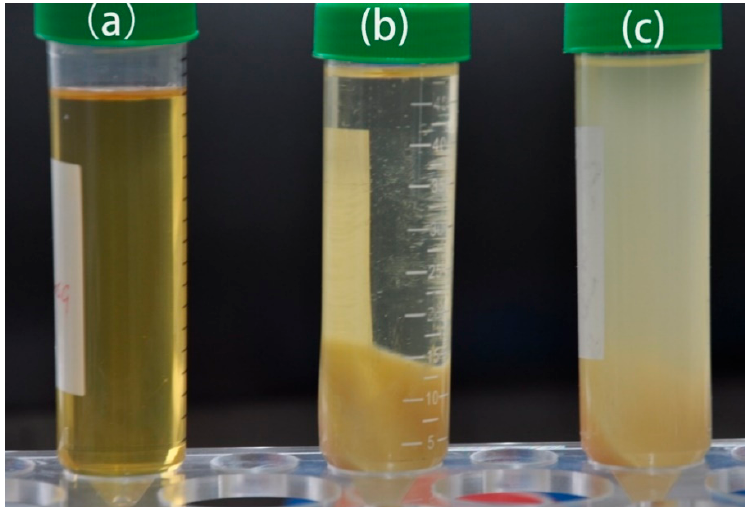
Figure 4. Separation of soap base and oil after alkaline refining at room temperature vs. 65 °C. ( a ) Jatropha curcas seed oil; ( b ) after KOH (1% w/w) treatment at room temperature; ( c ) after KOH (1% w/w) treatment at 65 °C.